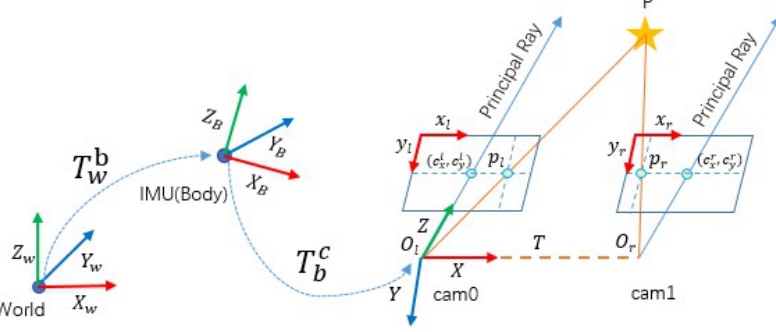
Figure 2. An illustration of coordinate system.